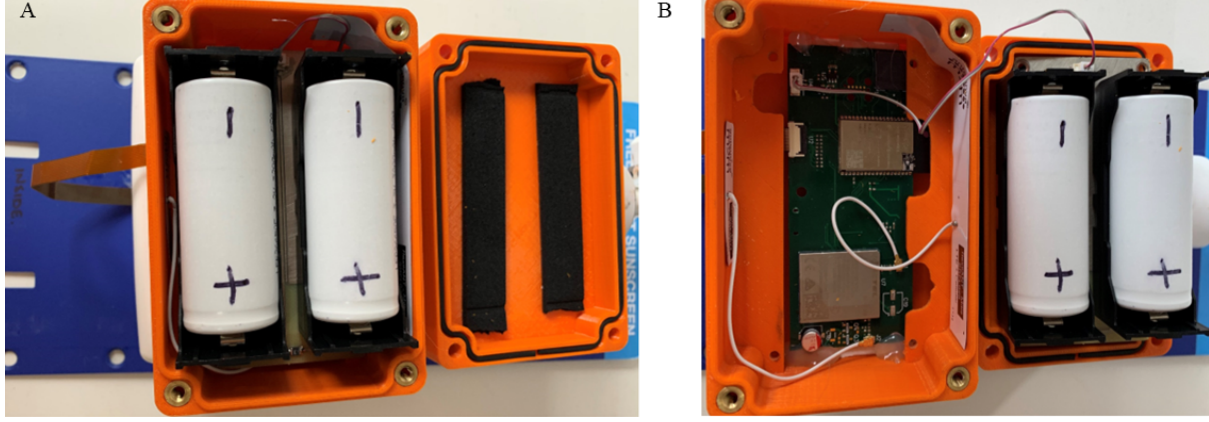
Figure 3. Smart sunscreen station electronic components; the battery housing was protected from water and dust using rubber seals (A), and the BG96 module was connected to a narrowband Internet of Things subscriber identification module (SIM) card and located underneath the battery platform with one NB1 radio antenna attached to the wall of the housing